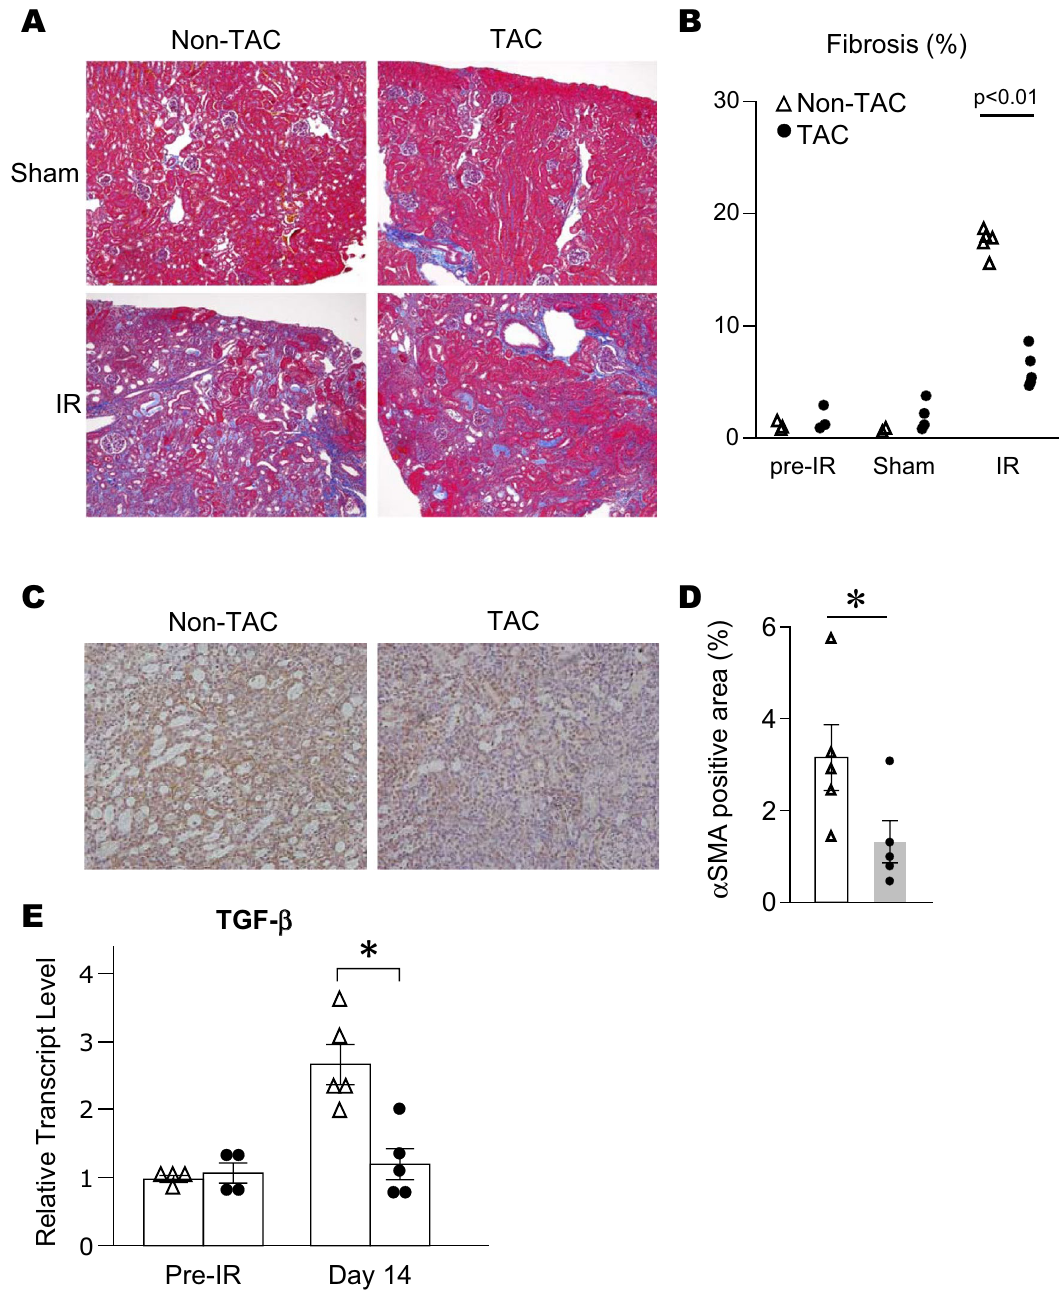
Figure 4. Renal interstitial fibrosis development after IR (Experiment 2). ( A ) Representative images of renal pathology with Masson Trichrome staining 14 days after IR. ( B ) Quantitative analysis of renal fibrotic areas (n = 4–5 per group). ( C ) Representative images of α-SMA staining 14 days after IR. ( D ) Quantitative analysis of α-SMA positive area (n = 4–5 per group). ( E ) mRNA levels of TGF-β is shown (n = 4–5 per group). *p < 0.05. Open triangle, non-TAC mice; filled circle, TAC mice. All graphs were created using JMP 14.0 software (SAS Institute Inc., Cary,